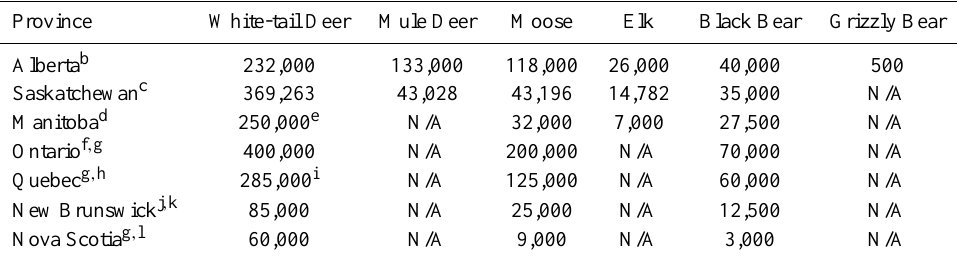
Table A6. Populations of Canadian wild animals a